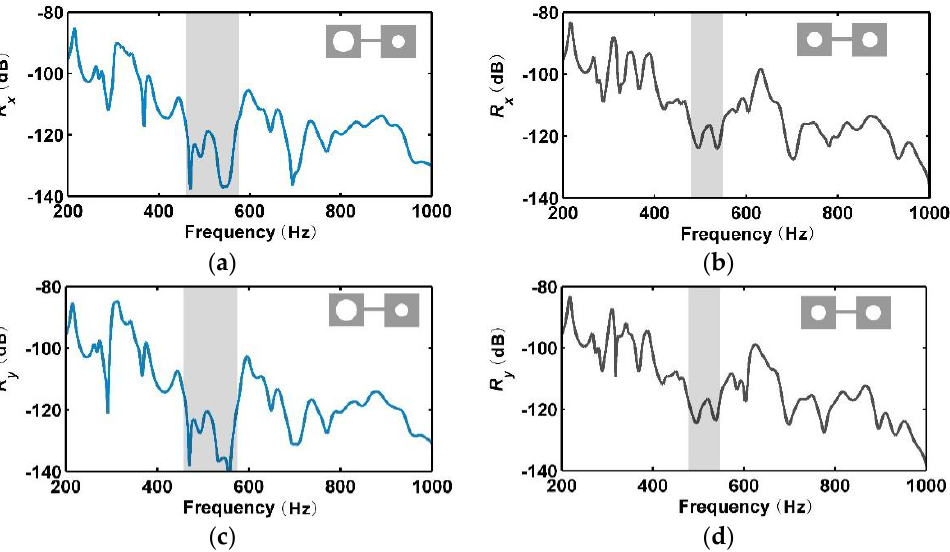
Figure 2. Receptance functions of the rainbow metamaterial in the x- ( a ) and y- ( c ) directions, and of the periodic metamaterial in the x- ( b ) and y- ( d ) directions from numerical simulations. The bandgaps are marked in grey.